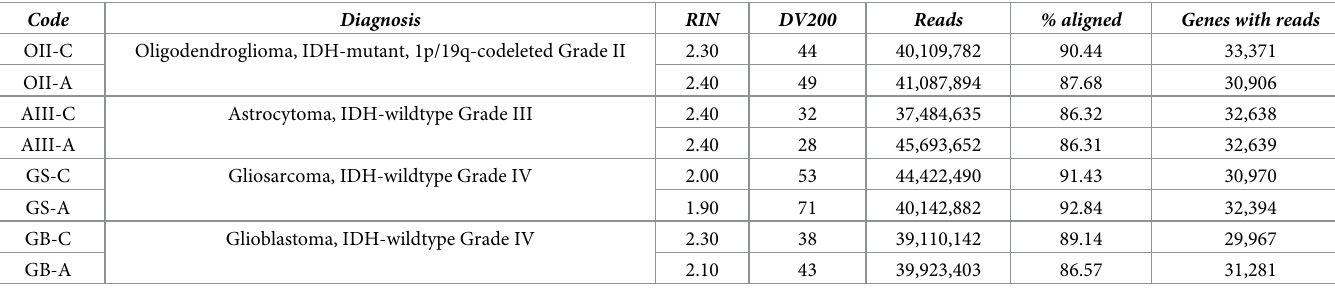
Table 1. Characteristics of the samples used in the present